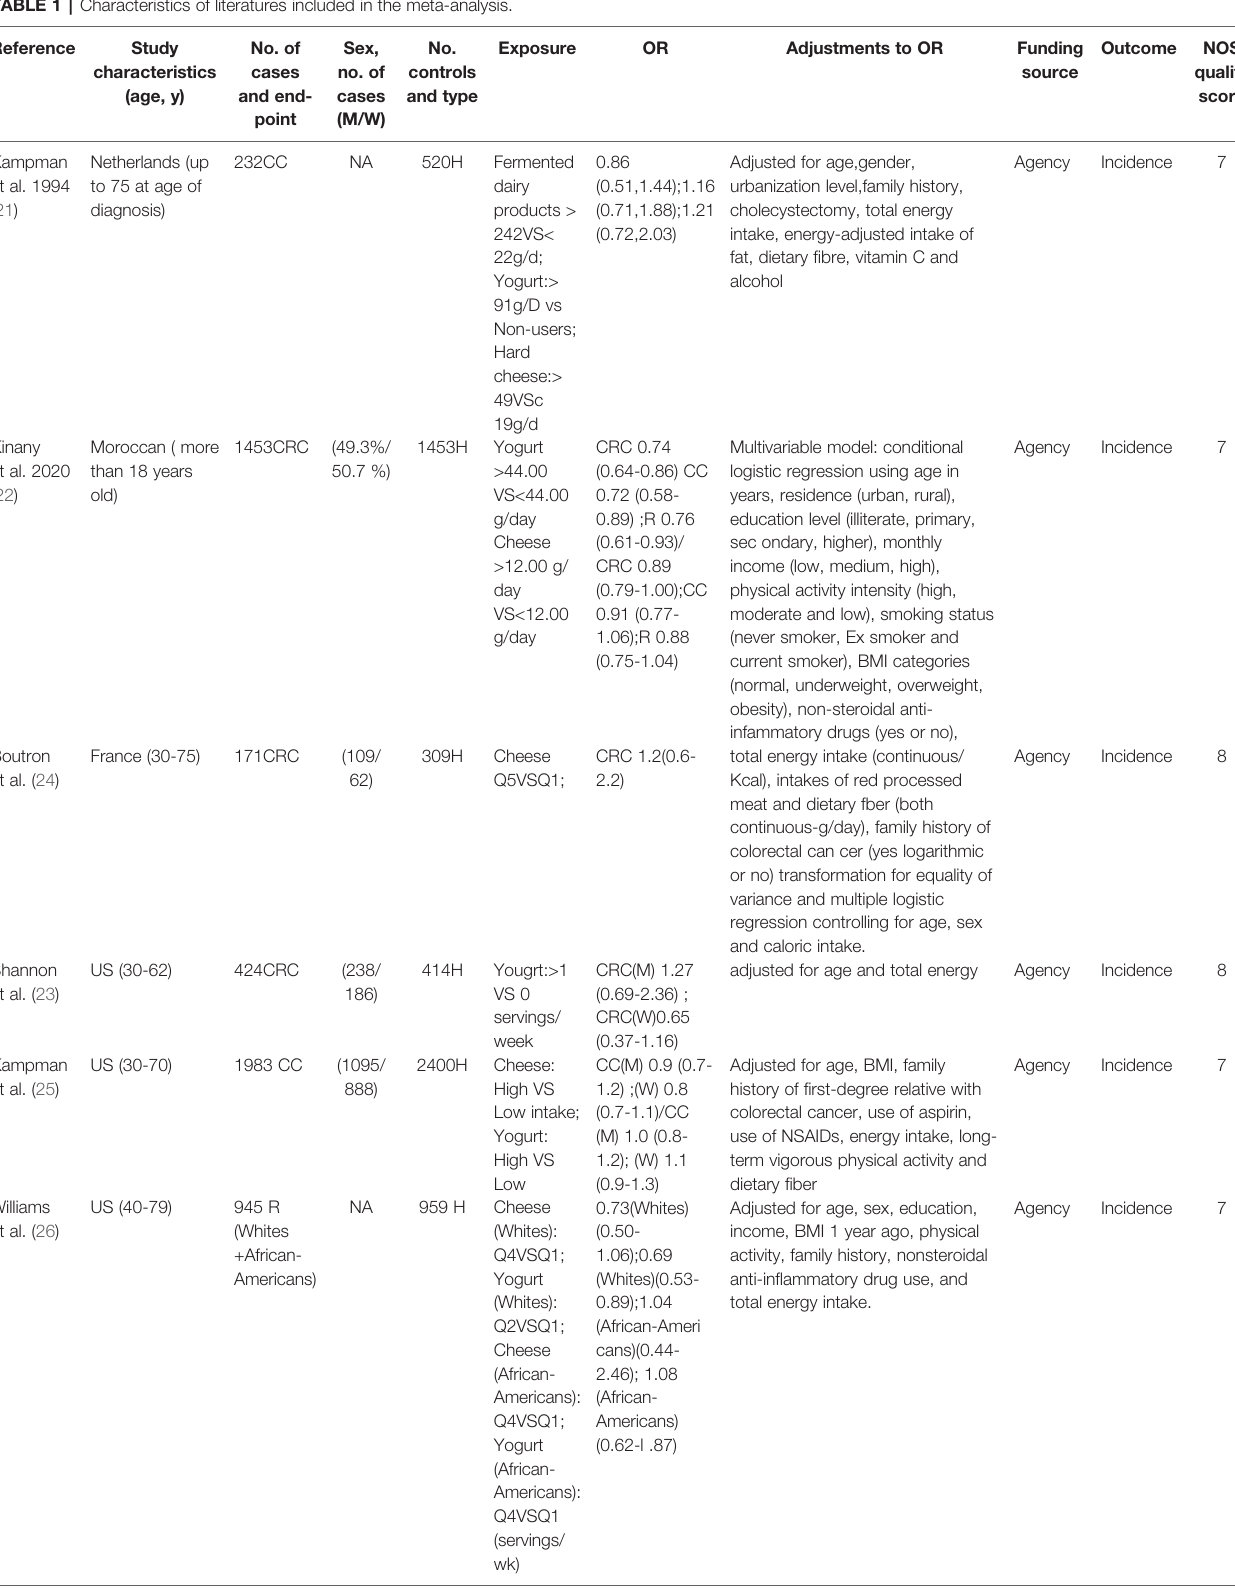
TABLE 1 | Characteristics of literatures included in the